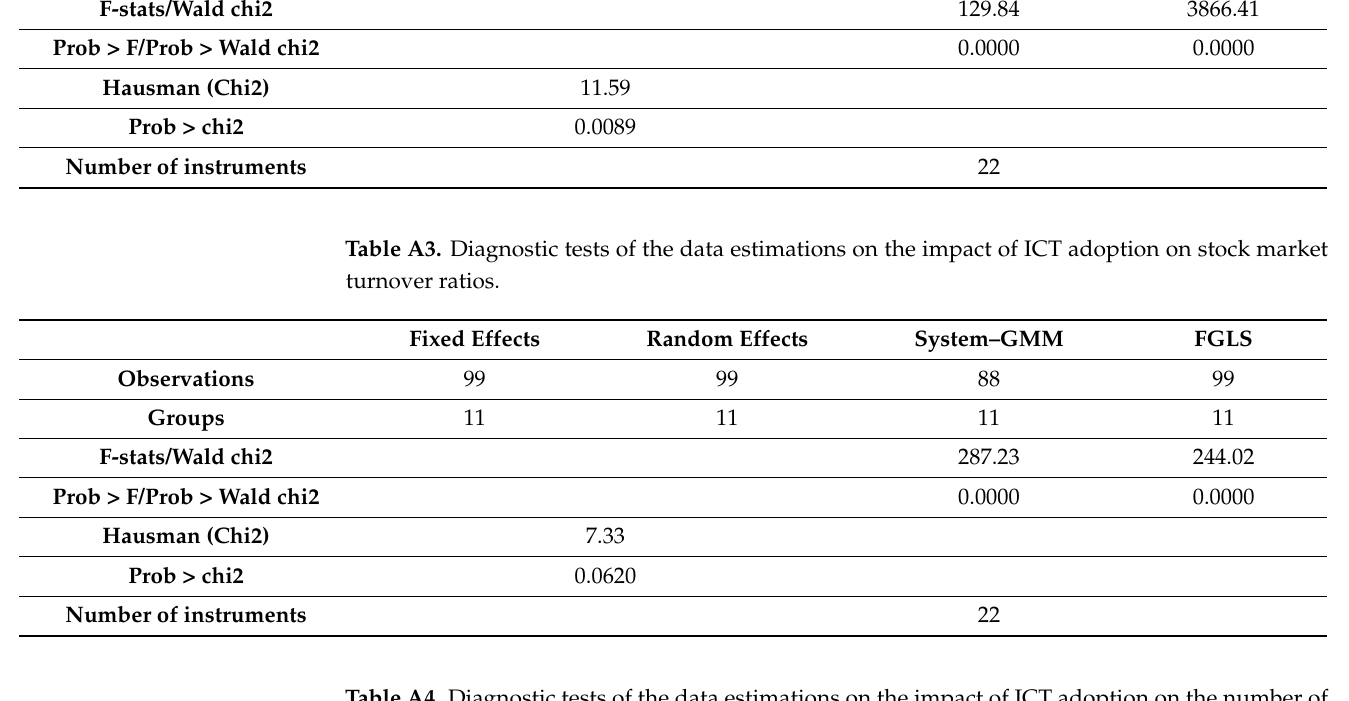
Table A4. Diagnostic tests of the data estimations on the impact of ICT adoption on the number of listed